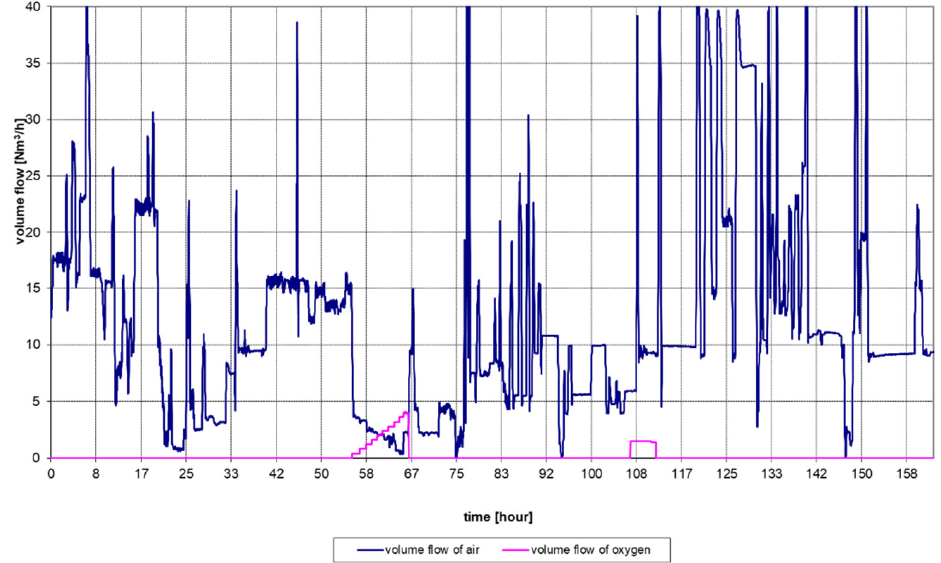
Figure 12. The volume flow of the oxidizers course during the first experiment.